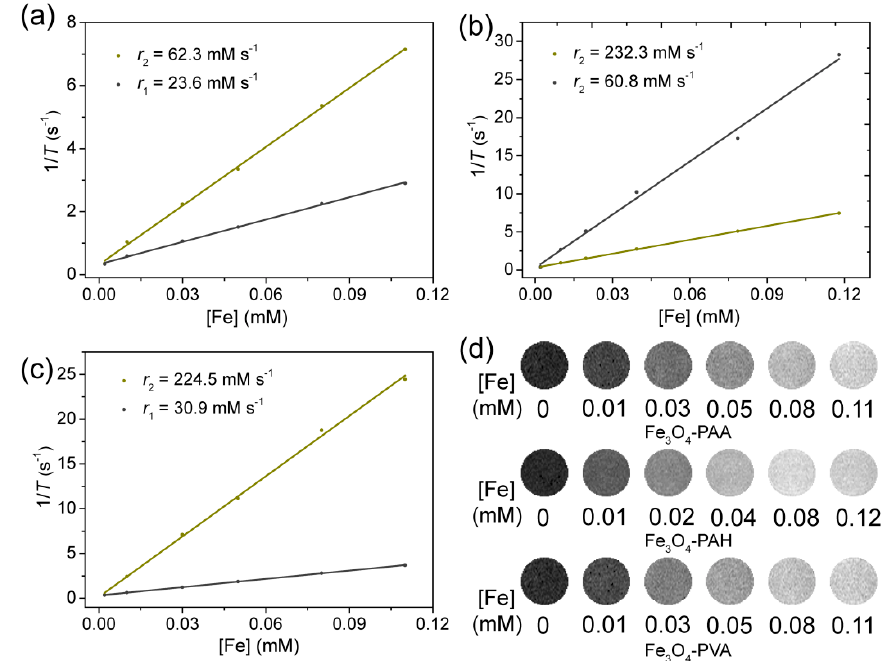
Figure 3. Plot of 1/ T against Fe concentration for ( a ) Fe 3 O 4 -PAA, ( b ) Fe 3 O 4 -PAH, and ( c ) Fe 3 O 4 -PVA nanoparticles. The values of r 1 and r 2 were calculated based on the slopes of the corresponding fitting lines (B 0 = 1 T, 25 °C). The T 1 ° and T 2 ° values of pure water were 2.79 and 3.01 s, respectively. (d) T 1 - weight MR images of the aqueous dispersion of Fe 3 O 4 -PAA, Fe 3 O 4 -PAH, and Fe 3 O 4 -PVA nanoparticles with different Fe